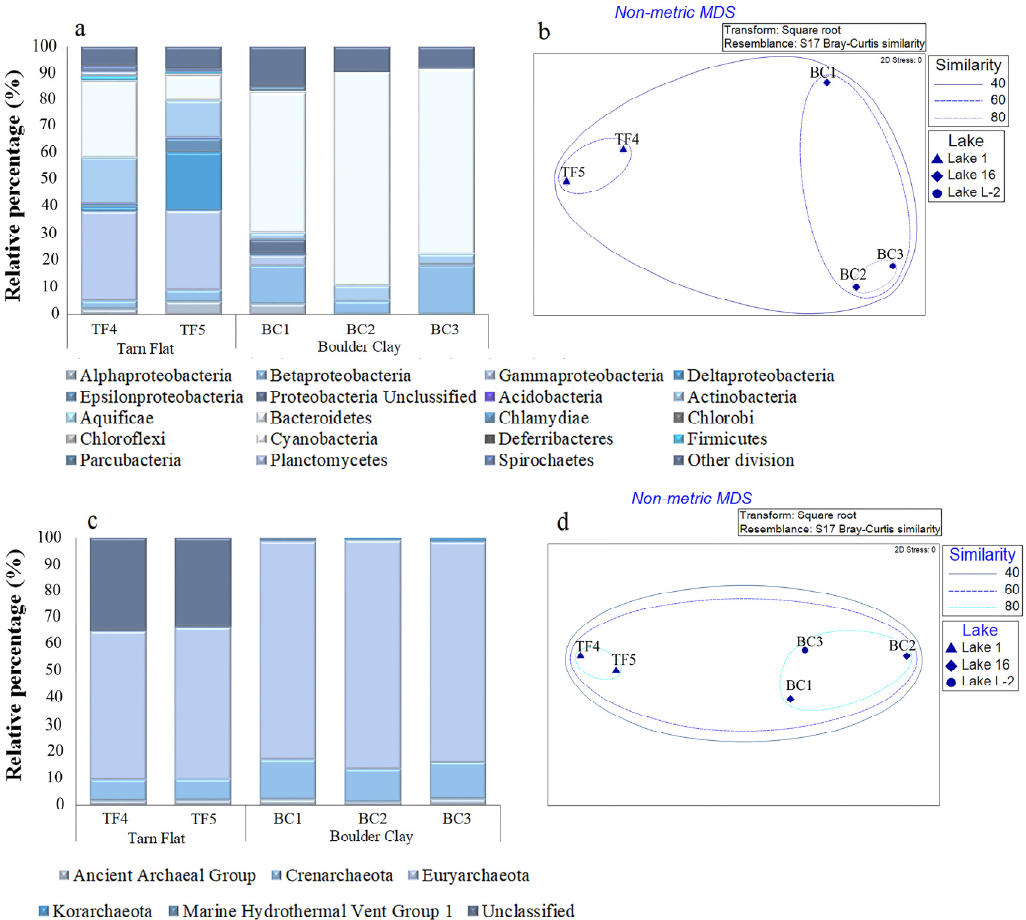
Figure 3. Bacterial ( a ) and archaeal ( c ) community composition at phylum level in TF and BC brines. Nonmetric multidi- mensional scaling analysis (nMDS) computed on transformed and clustered abundance data for bacterial ( b ) and archaeal ( d ) taxonomic groups at the phylum level.